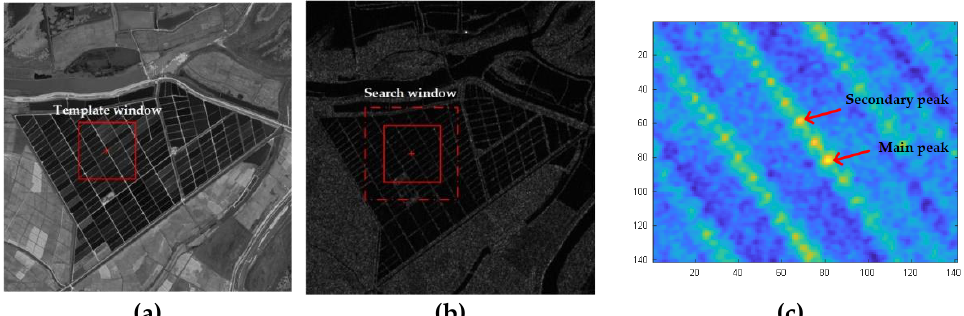
Figure 7. Similarity surface multi-peak phenomenon. ( a ) Optical image template window; ( b ) SAR image search window; ( c ) search surface map.